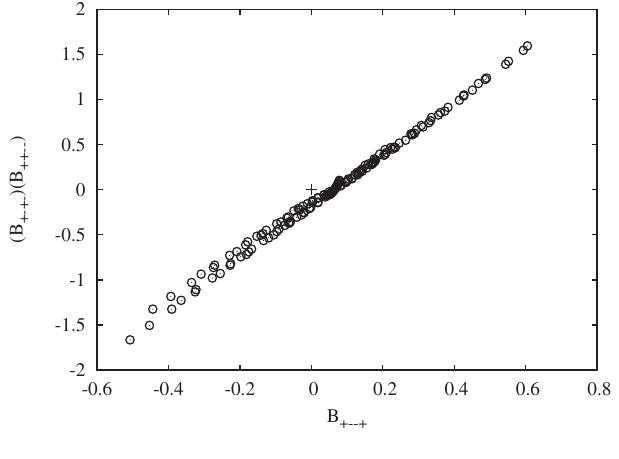
FIG. 5. B þ(cid:3)þ(cid:3) B þþ(cid:3)(cid:3) vs B þ(cid:3)(cid:3)þ for points on a 18 mm by 10 mm grid with button intensity computed with the nonlinear map. The button 4 signal is reduced by 5% with respect to buttons 1, 2, and 3. [The gains ð 1:4 Þ ¼ 1 ; 1 ; 1 ; 0 : 95 .] The þ indicates the coordinate (0,0).